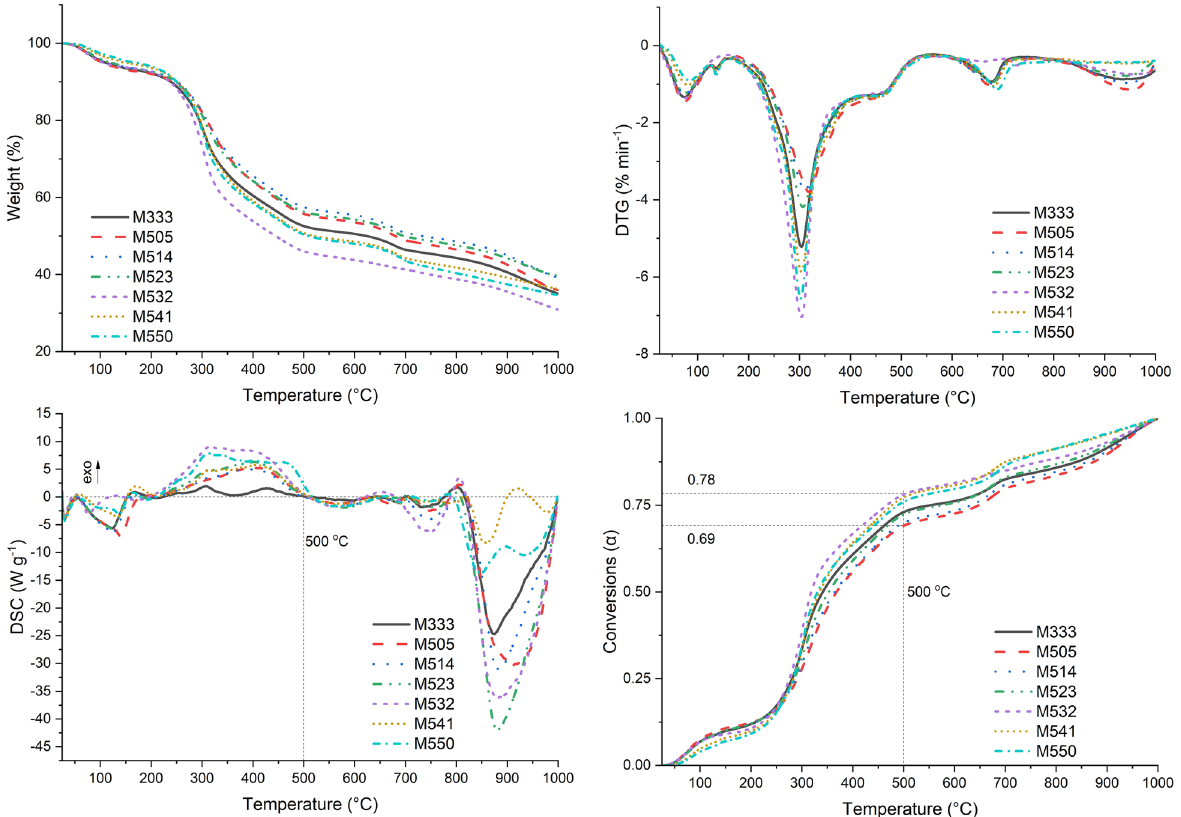
Fig. 3 The thermograms – TG, DTG, conversions, and DSC curves – during the pyrolysis of MM at 15 °C min − 1 . In DSC, curves below 0 W g − 1 denote endothermic heat